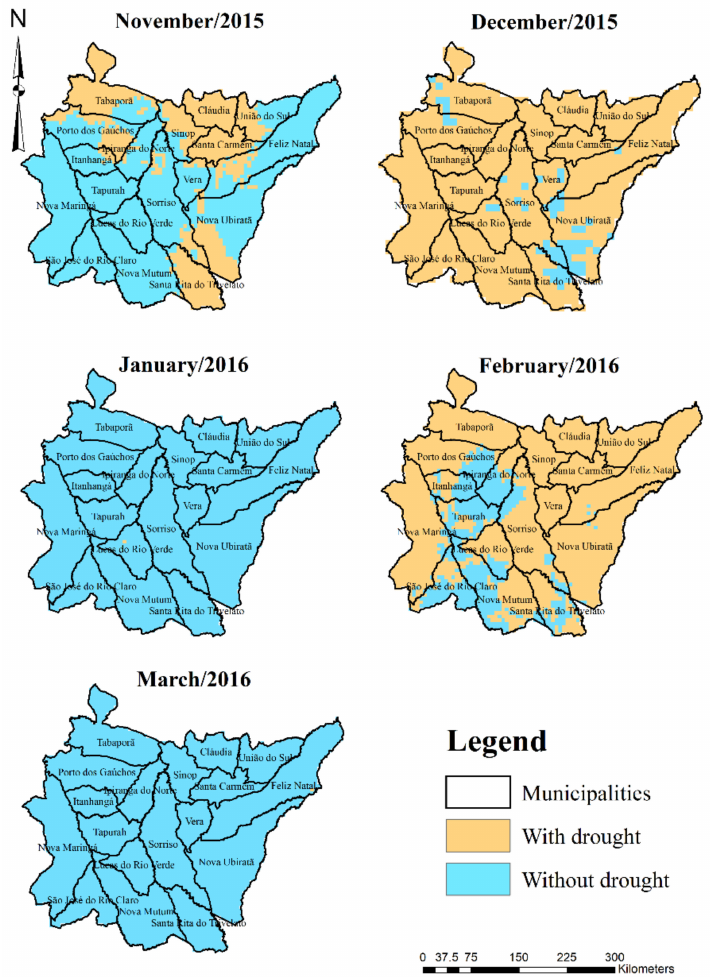
Figure 5. Drought maps resulting from the calculation of SPI-1 with CHIRPS-2.0 (November, January, February and March) and GPM-3IMERGMv6 data (December) for the period from November 2015 to March 2016 in the north–central region of the State of Mato Grosso,